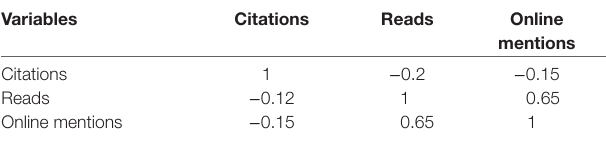
TaBle 5 | Correlation matrix for case study author-level metrics ( n = 34).